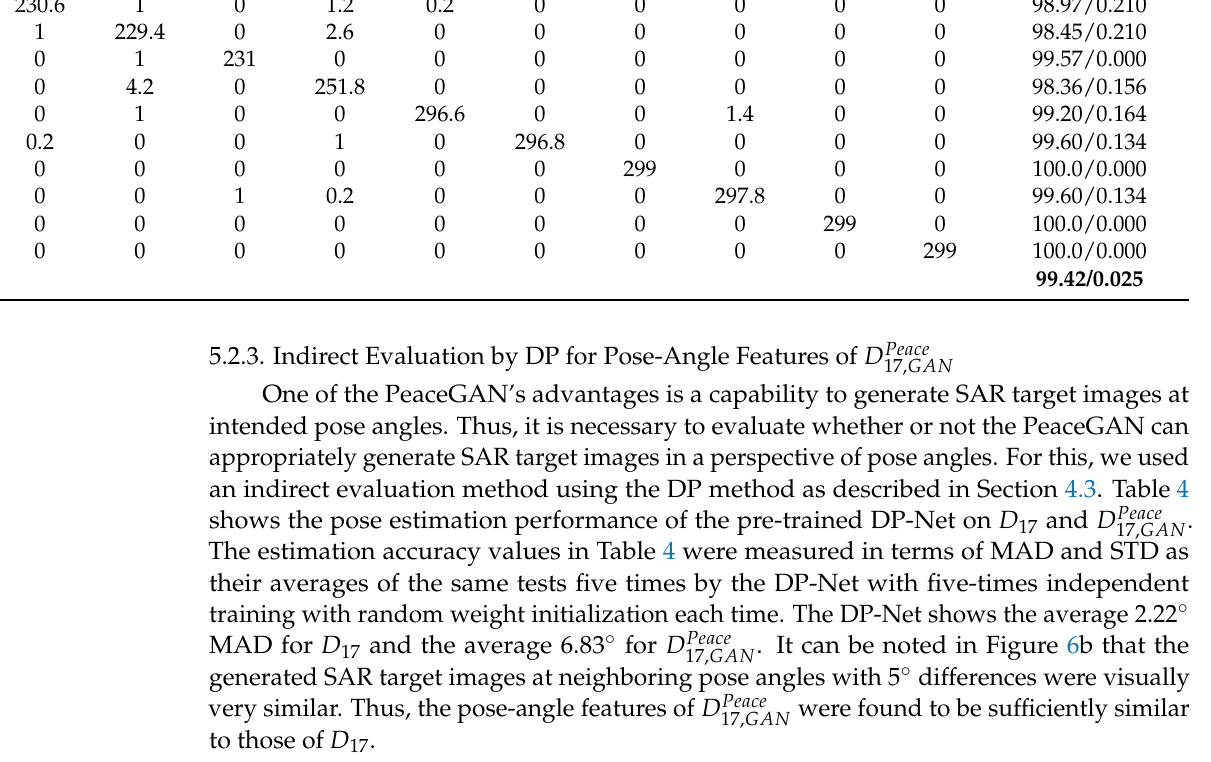
Table 3. Confusion matrix for target recognition performance (%) on D Peace